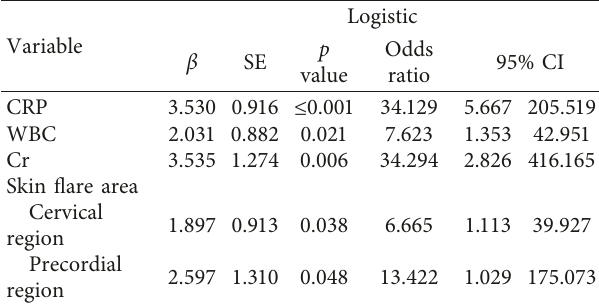
Table 2: Factors with a significant association with OCNF in univariate analysis ( χ 2 test).